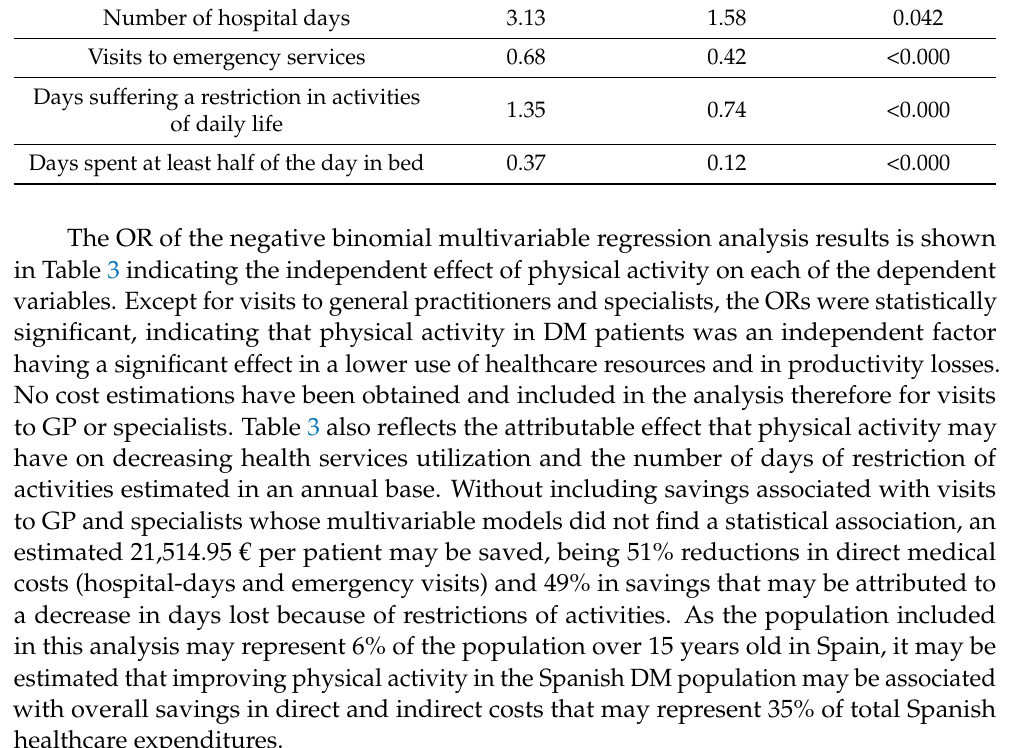
Table 2. Mean values of use of services and days of loss of productivity losses in diabetic persons. Sedentary Physical Activity p Visits to General Practitioners or family doctors